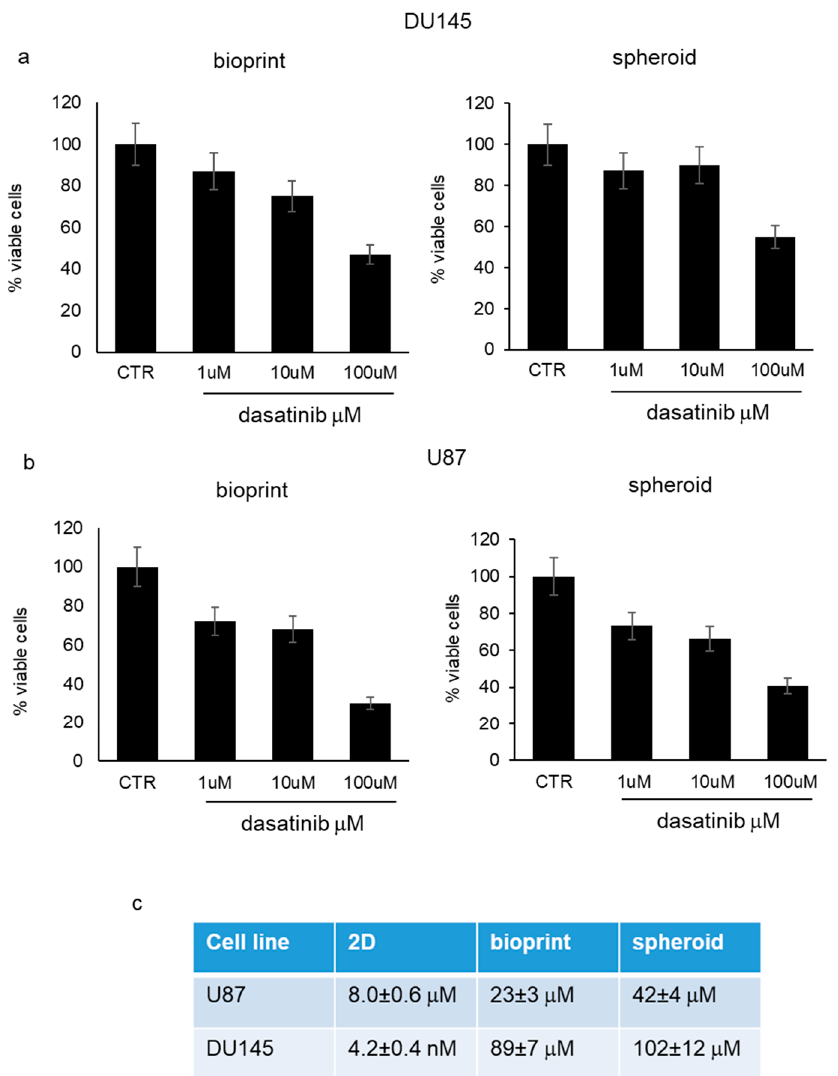
Figure 2. Antiproliferative effect of dasatinib in 3D cell models. ( a ) Percentage of viable DU145 cells in bioprints ( left ) and in spheroids ( right ) 72 h after treatment with increasing concentrations of dasatinib (1, 10, and 100 µ M). The mean values measured in untreated cells were adjusted at 100%. Each value represents the mean of five different measurements ( ± standard deviation). ( b ) Percentage of viable U87 cells in bioprints ( left ) and in spheroids ( right ) 72 h after treatment with increasing concentrations of dasatinib (1, 10, and 100 µ M). The mean values measured in untreated cells were adjusted at 100%. Each value represents the mean of five different measurements ( ± standard deviation). ( c ) Mean IC50 values calculated for U87 and DU145 cells treated with dasatinib for 72 h. The IC50s were calculated in standard culture conditions (2D), in 3D bioprint model (bioprint), and in spheroids and were the result of three different experiments ( ± standard